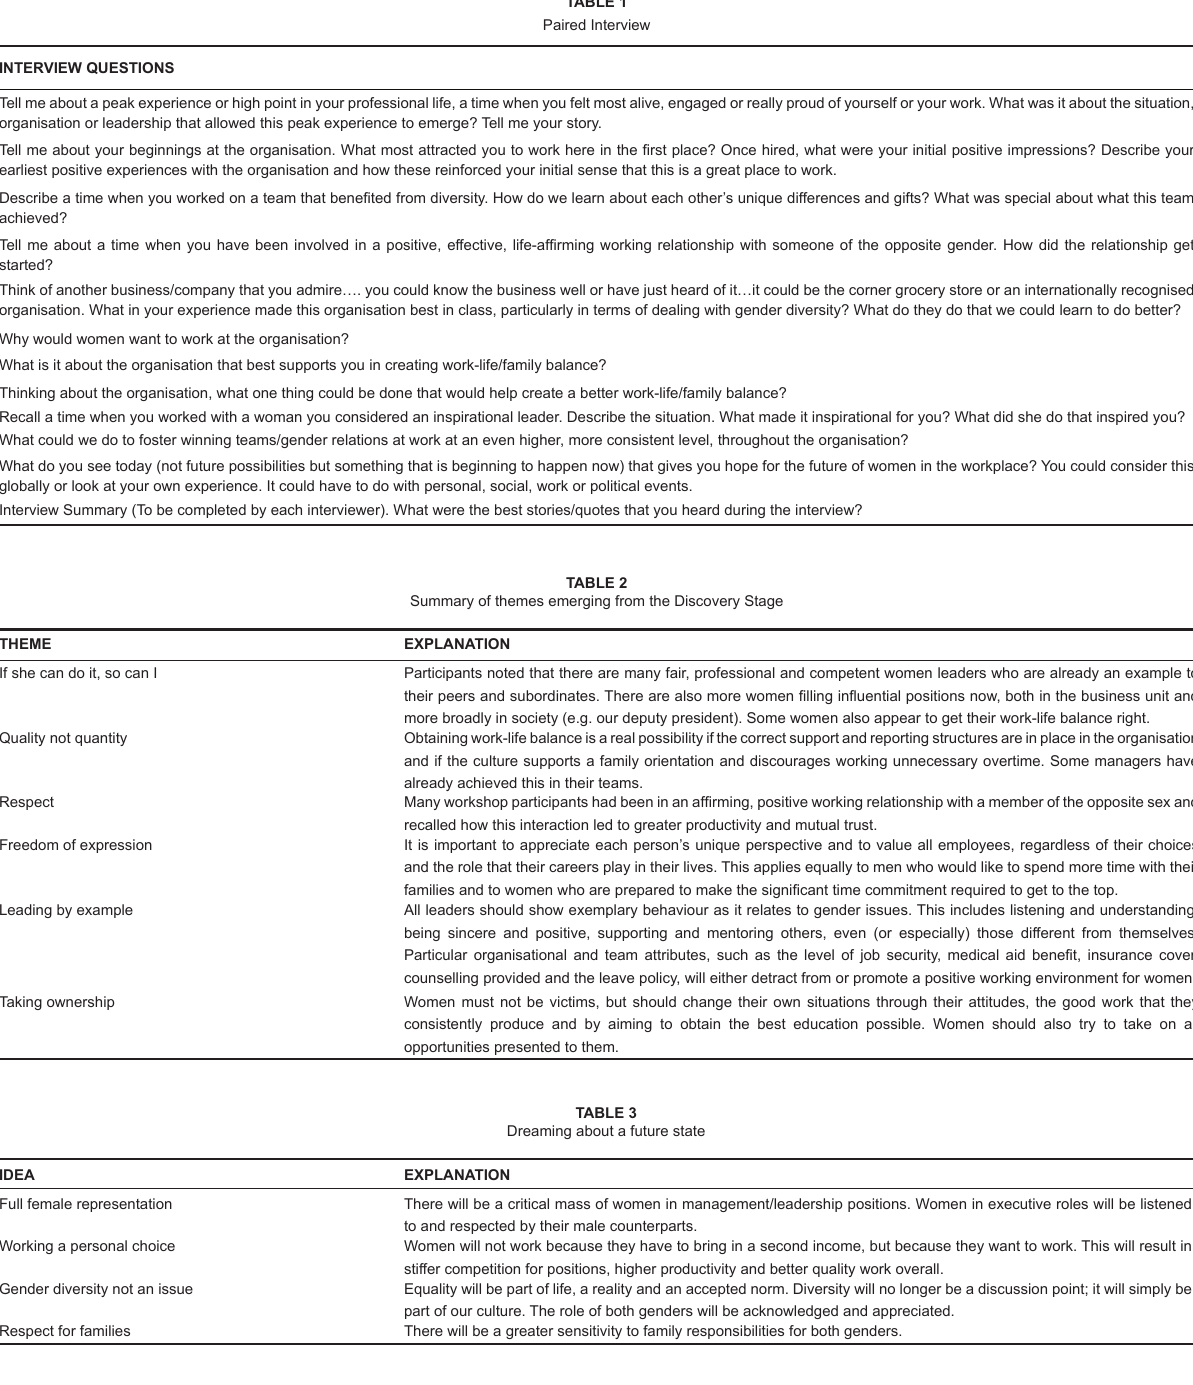
TABLE 4 Designing the future using metaphors and provocative